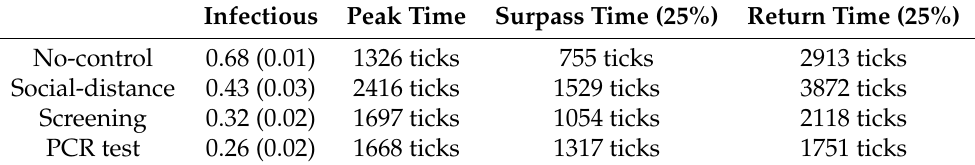
Table 2. Summary of control measure effects